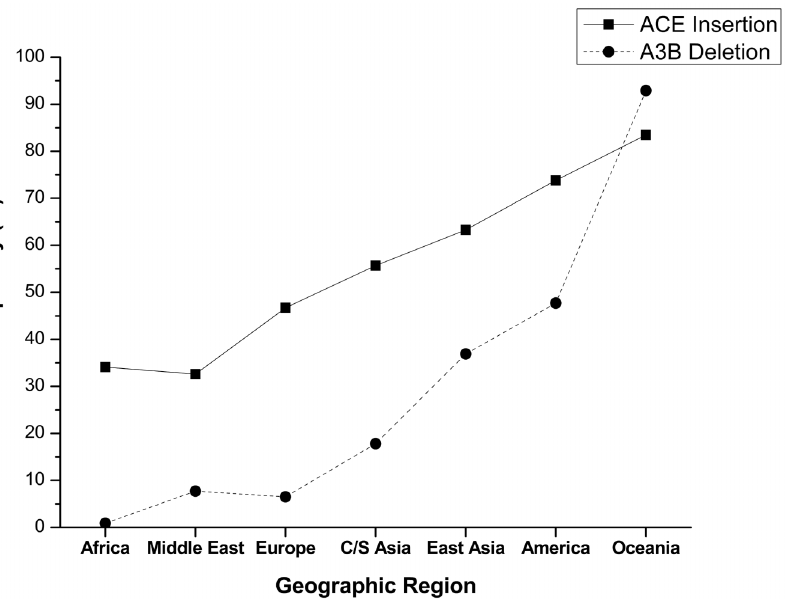
Figure 1. Variation curves of ACE insertion and A3B deletion distributions among different geographic regions. ‘C/S Asia’ corresponds to Central South Asia. America refers to Amerindians; Oceania refers to Oceania aboriginals.